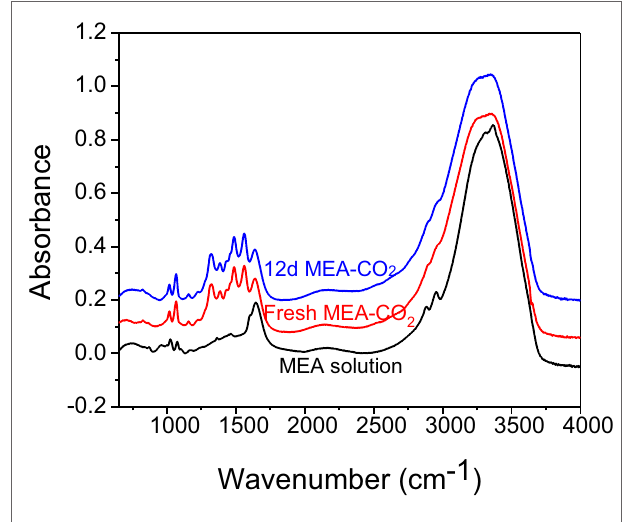
FigUre 6 | FTir spectra of 30 wt% Mea aqueous solution, fresh Mea-cO 2 solution and the residual Mea-cO 2 solution after 12-day of “cO 2 replenishment” reaction .